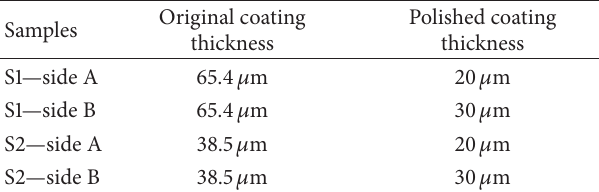
Table 3: Original and polished thicknesses of the PEO coatings. Original coating Polished Samples